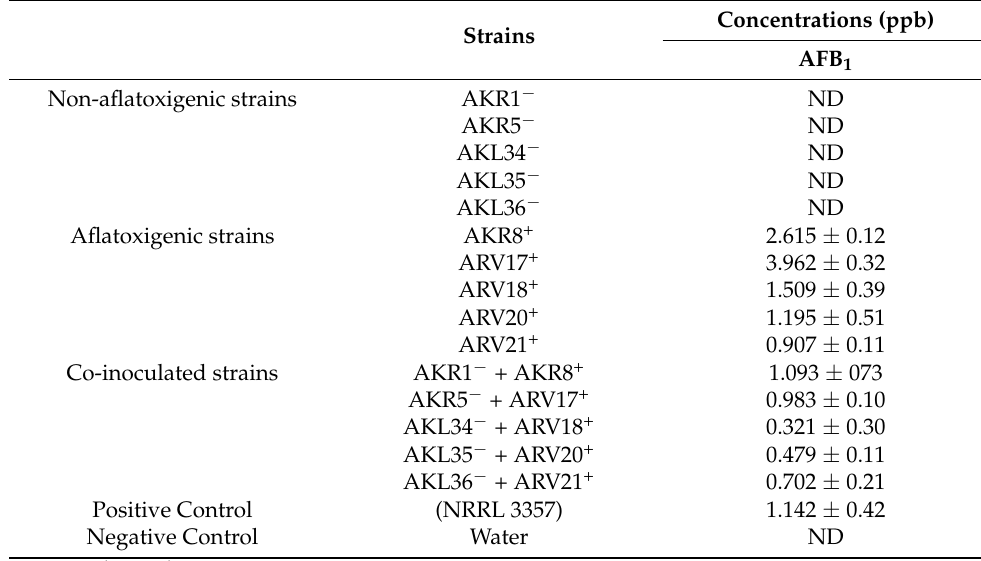
Figure 6. The percentages of reductions in AFB 1 by the AF − strains following seven days of incubation. Table 2. Detection of AFB 1 in AF + and co-inoculated (AF + − AF − ) strains following seven days of incubation.